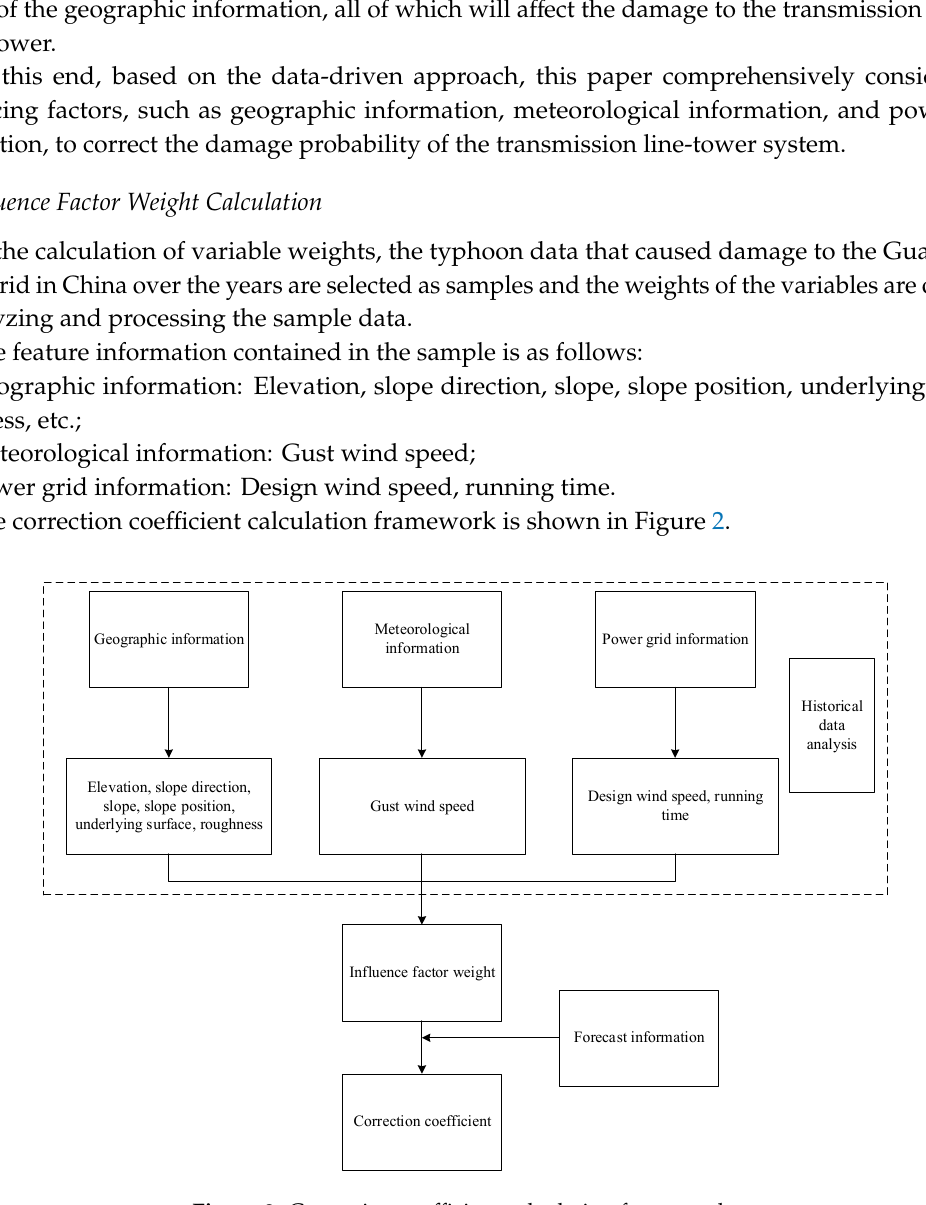
Figure 2. Correction coefficient calculation framework. 149